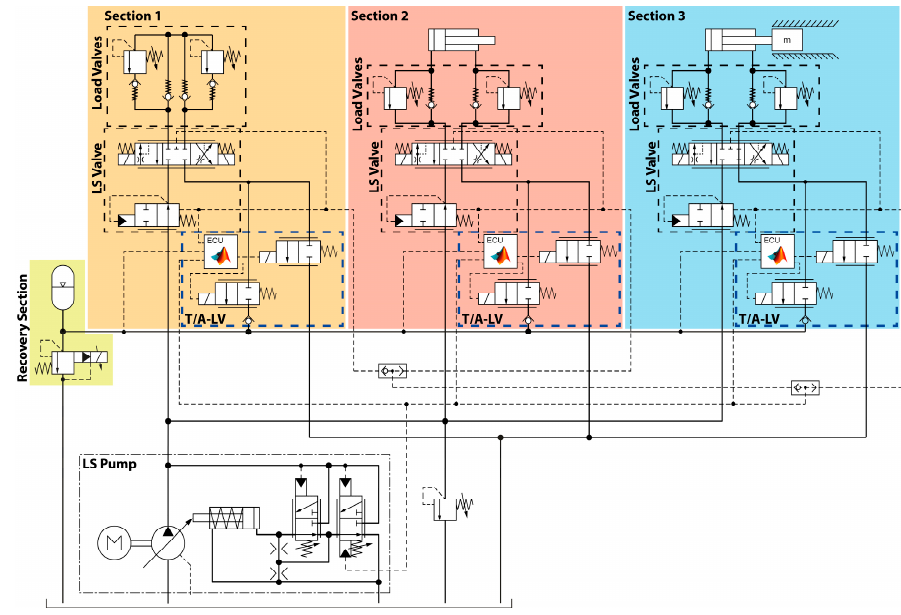
Figure 18. Simulation Model of the optimized LS System [9]. Reproduced with permission from publisher.